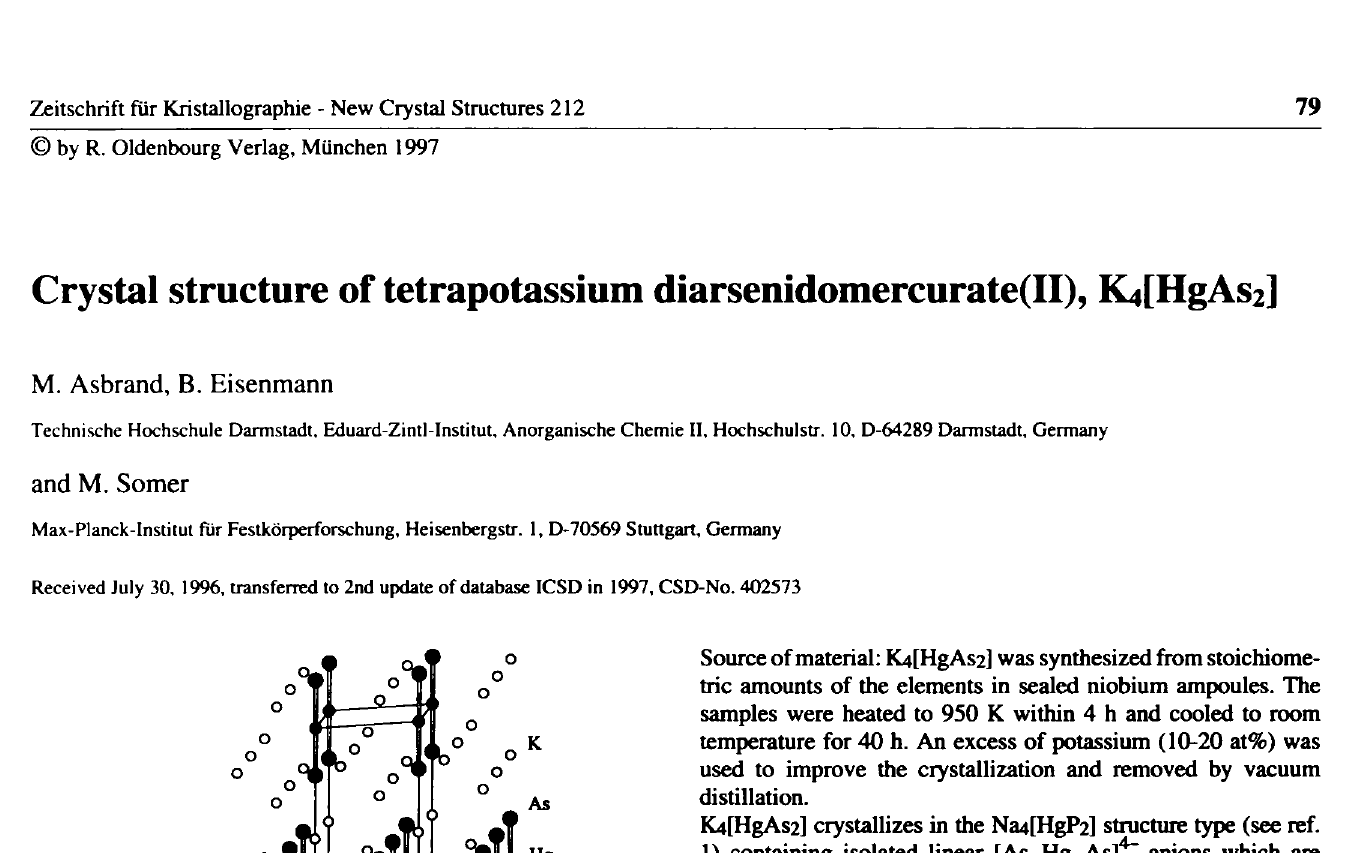
Table 2. Final atomic coordinates and displacement parameters (in Â 2 )